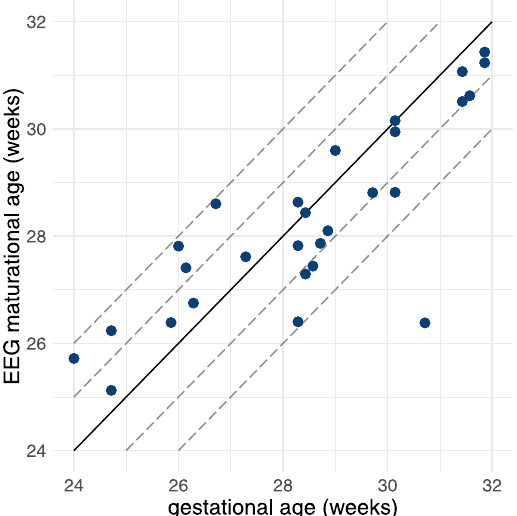
Figure 5. Algorithm’s estimation of EEG maturational age from testing results comparative to gestational age for n = 28 infants. Correlation coefficient is r = 0.83. Dashed lines represent 1 and 2 weeks deviation from the ideal 1:1 representation (solid